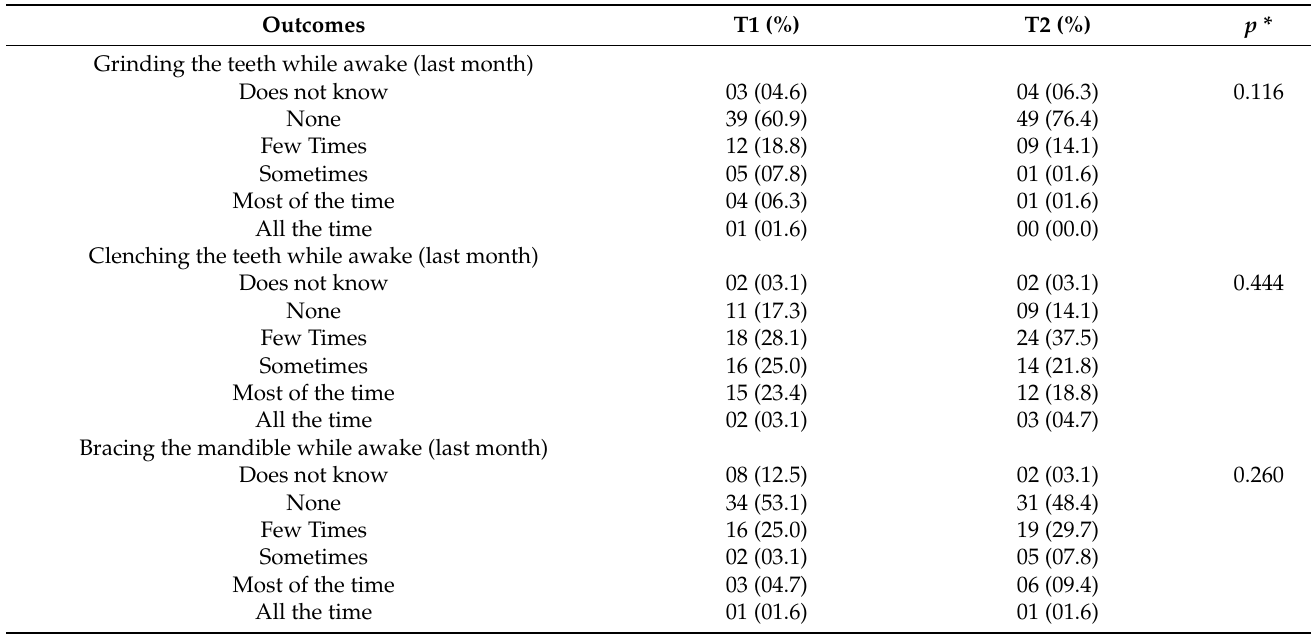
Table 2. Comparative analysis between awake bruxism reported before the pandemic (T1) and in the first period of mandatory confinement by COVID-19